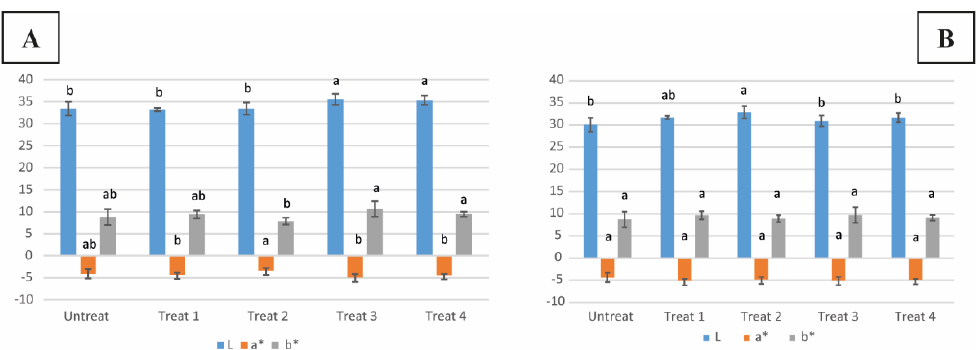
Figure 4. Color parameters of leaves in ( A ) t1 and ( B ) t2. Different letters indicate statistical differences at p < 0.05 with Tukey’s test.